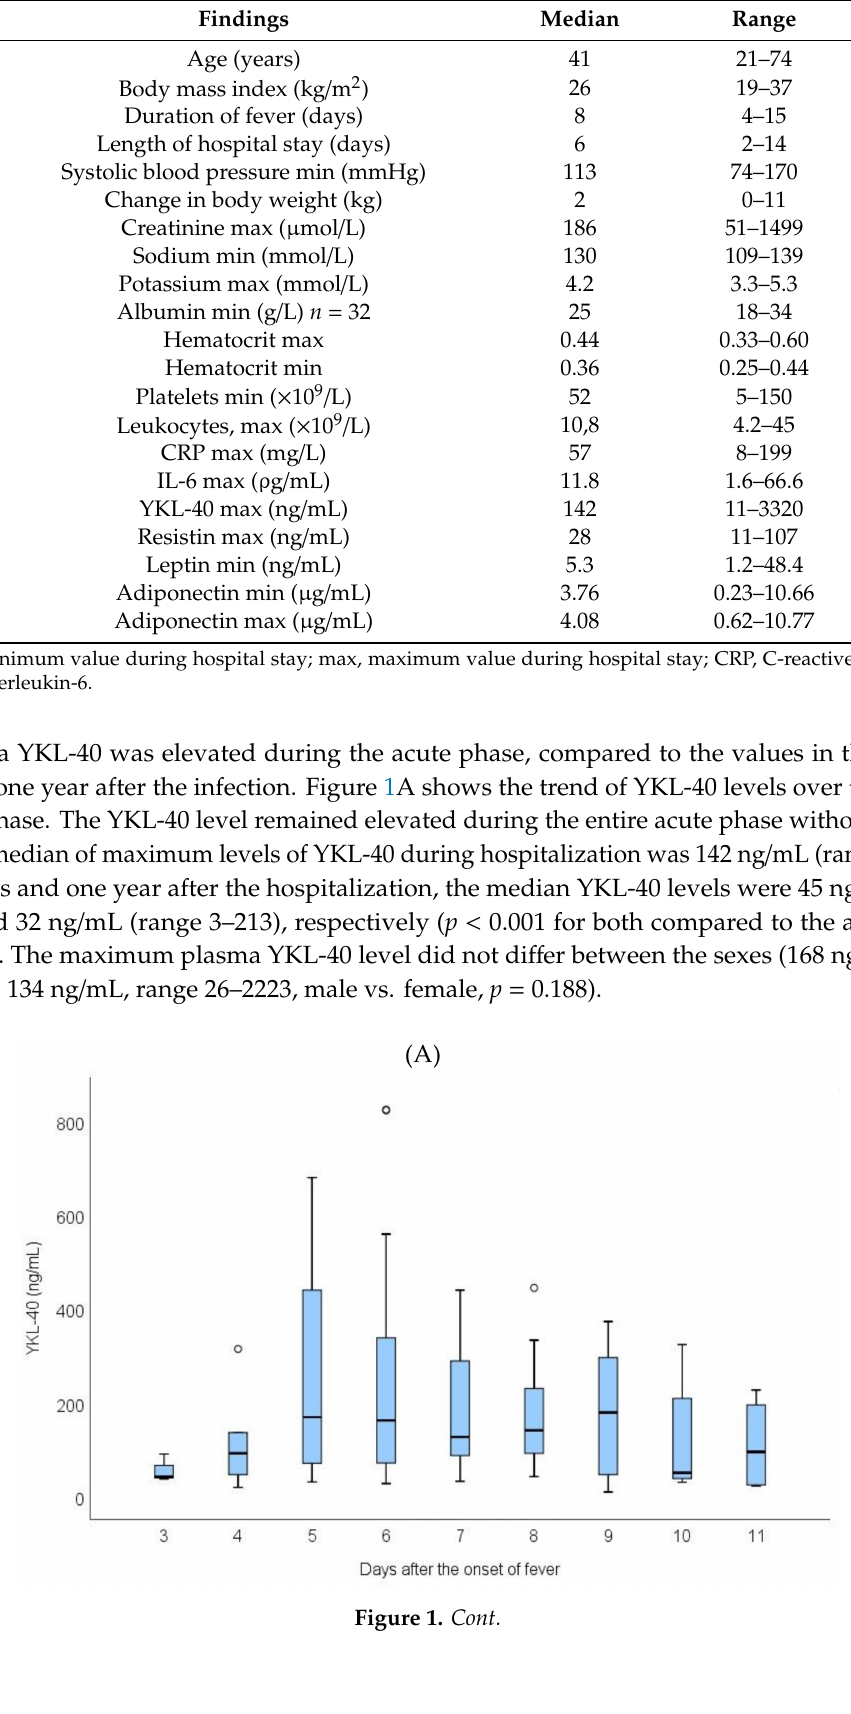
Table 1. Clinical and laboratory findings in 79 patients with Puumala hantavirus infection.